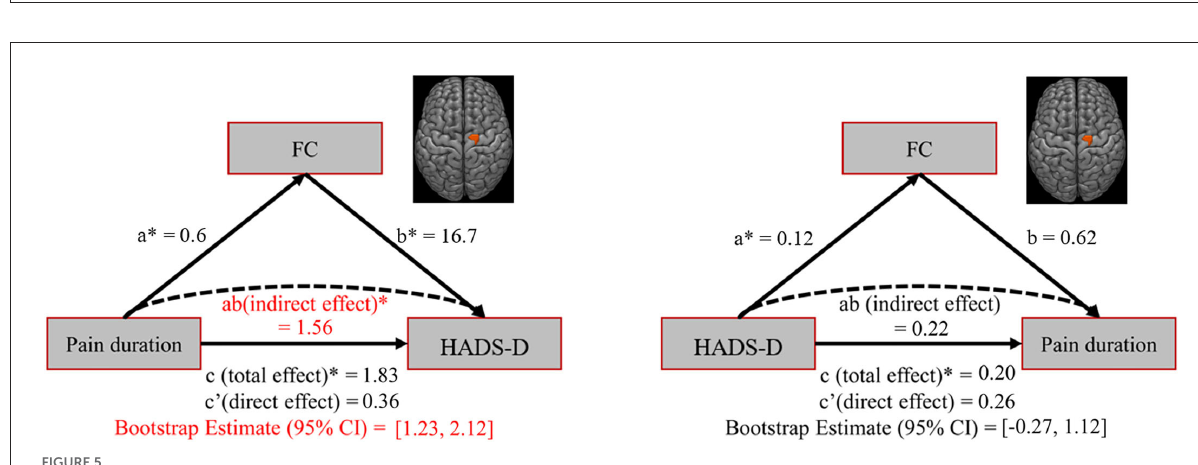
FIGURE5 Mediation analysis. (Left) The effect of pain duration on HADS-D was mediated by the Thalamus-SI functional connectivity. Path c is the total effect of pain duration on HADS-D; path c’ is the direct effect of pain duration on HADS-D after controlling for the Thalamus-SI functional connectivity; the product of a and b (ab) is the indirect effect of pain duration through the Thalamus-SI functional connectivity on HADS-D. (Right) The effect of HADS-D on pain duration was not mediated by the Thalamus-SI functional connectivity. Path c is the total effect of HADS-D on pain duration; path c’ is the direct effect of HADS-D on pain duration after controlling for the Thalamus-SI functional connectivity; the product of a and b (ab) is the indirect effect of HADS-D through the Thalamus-SI functional connectivity on pain duration. HADS-D, Hospital Anxiety and Depression Scale-Depression. *, p <